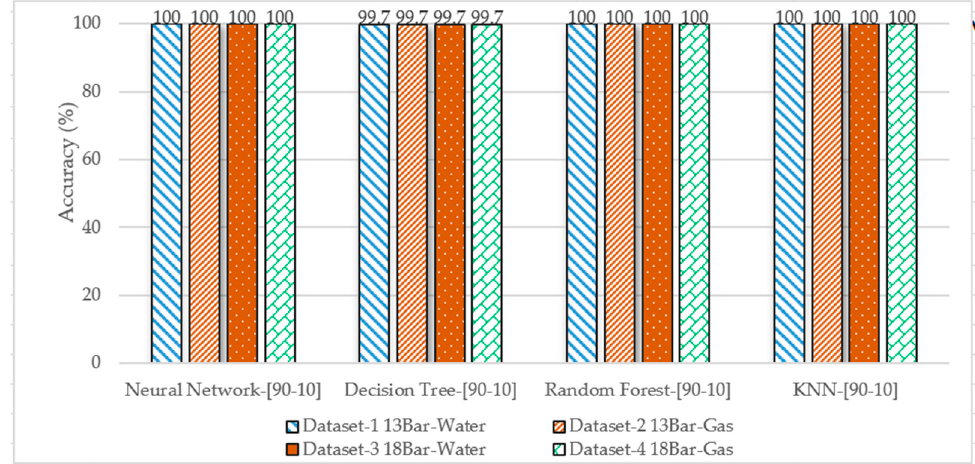
Figure 17. Performance comparison of the applied ML algorithms in terms of accuracy.